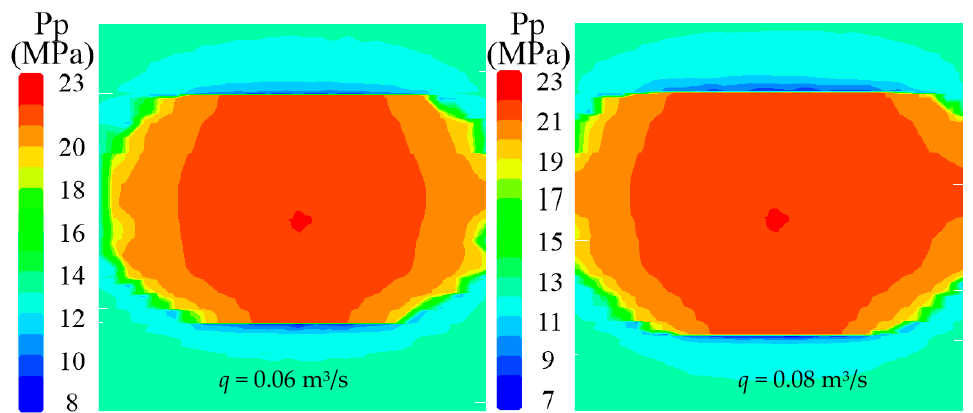
Figure 13. Fluid pressure distributions in different cases, with the injection rate varying from q = 0.02 m 3 /s to 0.04 m 3 /s, 0.06 m 3 /s and 0.08 m 3 /s. The injection rate can improve the fracture height and the fracture area (Figure 14).